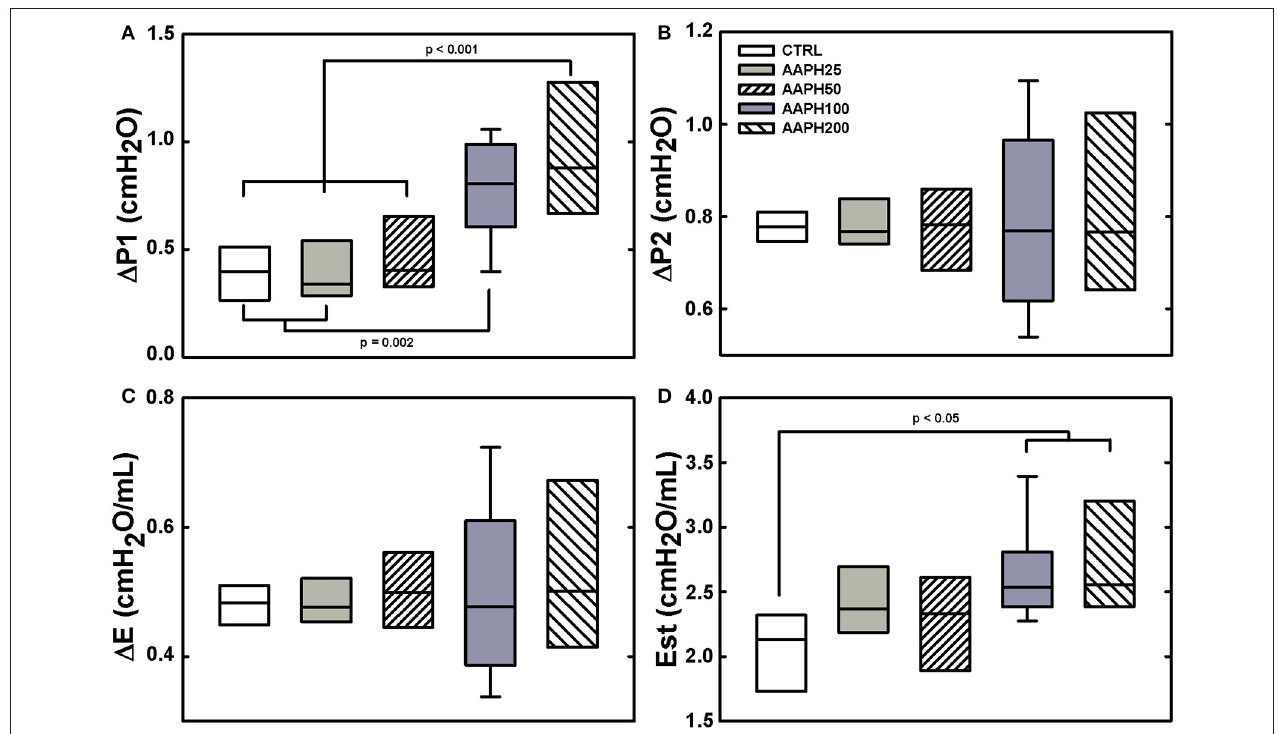
FIGURE 1 | Pulmonary mechanical data in rats. (A) Resistive pressure ( 1 P1). (B) Pressure dissipated to overcome viscoelastic/inhomogeneous mechanical components ( 1 P2). (C) Elastic component of viscoelasticity ( 1 E). (D) Static elastance (Est). Animals exposed to saline solution (CTRL) or different amounts of 2,2 ′ -azobis (2-amidinopropane) dihydrochloride (AAPH25, 50, 100, or 200 mg/kg in saline solution). Boxes show interquartile (25–75%) range, whiskers encompass 10–90% range, and horizontal lines represent median of 8 animals in each group. Differences among the groups are indicated by horizontal lines, above which the respective P -values can be found.